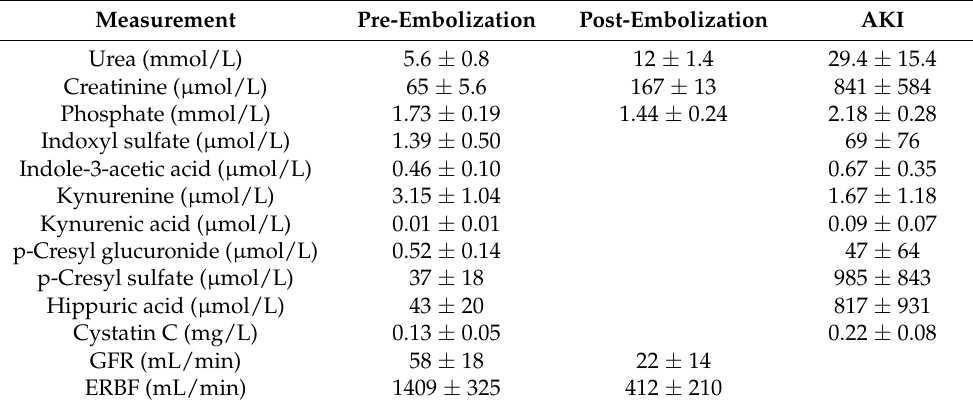
Figure 1. Embolization of the caudal pole of the left kidney. Perfusion of blood vessels in the cranial pole of the left kidney is visualized using contrast angiography. Table 1. The effect of embolization and gentamicin on plasma concentrations of urea, creatinine and phosphate and on glomerular filtration rate and effective renal blood flow.